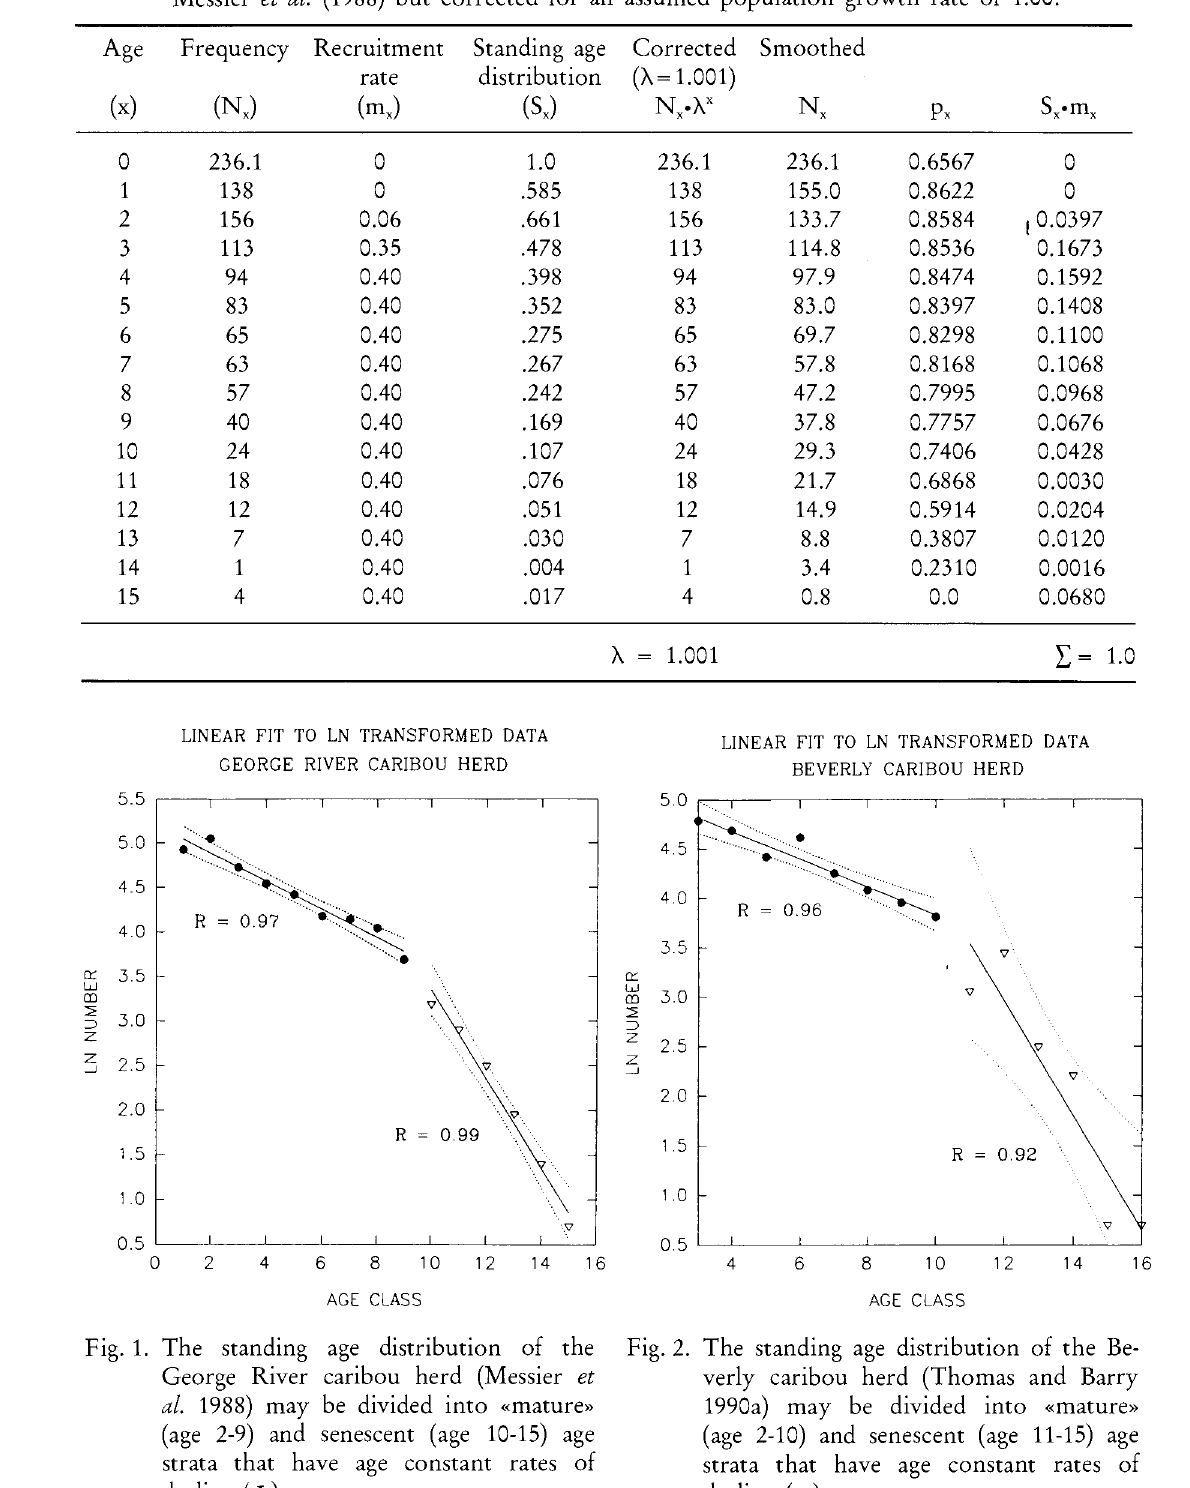
Fig. 1. The standing age distribution of the Fig. 2. The standing age distribution of the Be¬ George River caribou herd (Messier et verly caribou herd (Thomas and Barry al. 1988) may be divided into «mature» 1990a) may be divided into «mature» (age 2-9) and senescent (age 10-15) age (age 2-10) and senescent (age 11-15) age strata that have age constant rates of strata that have age constant rates of decline (<t>). decline